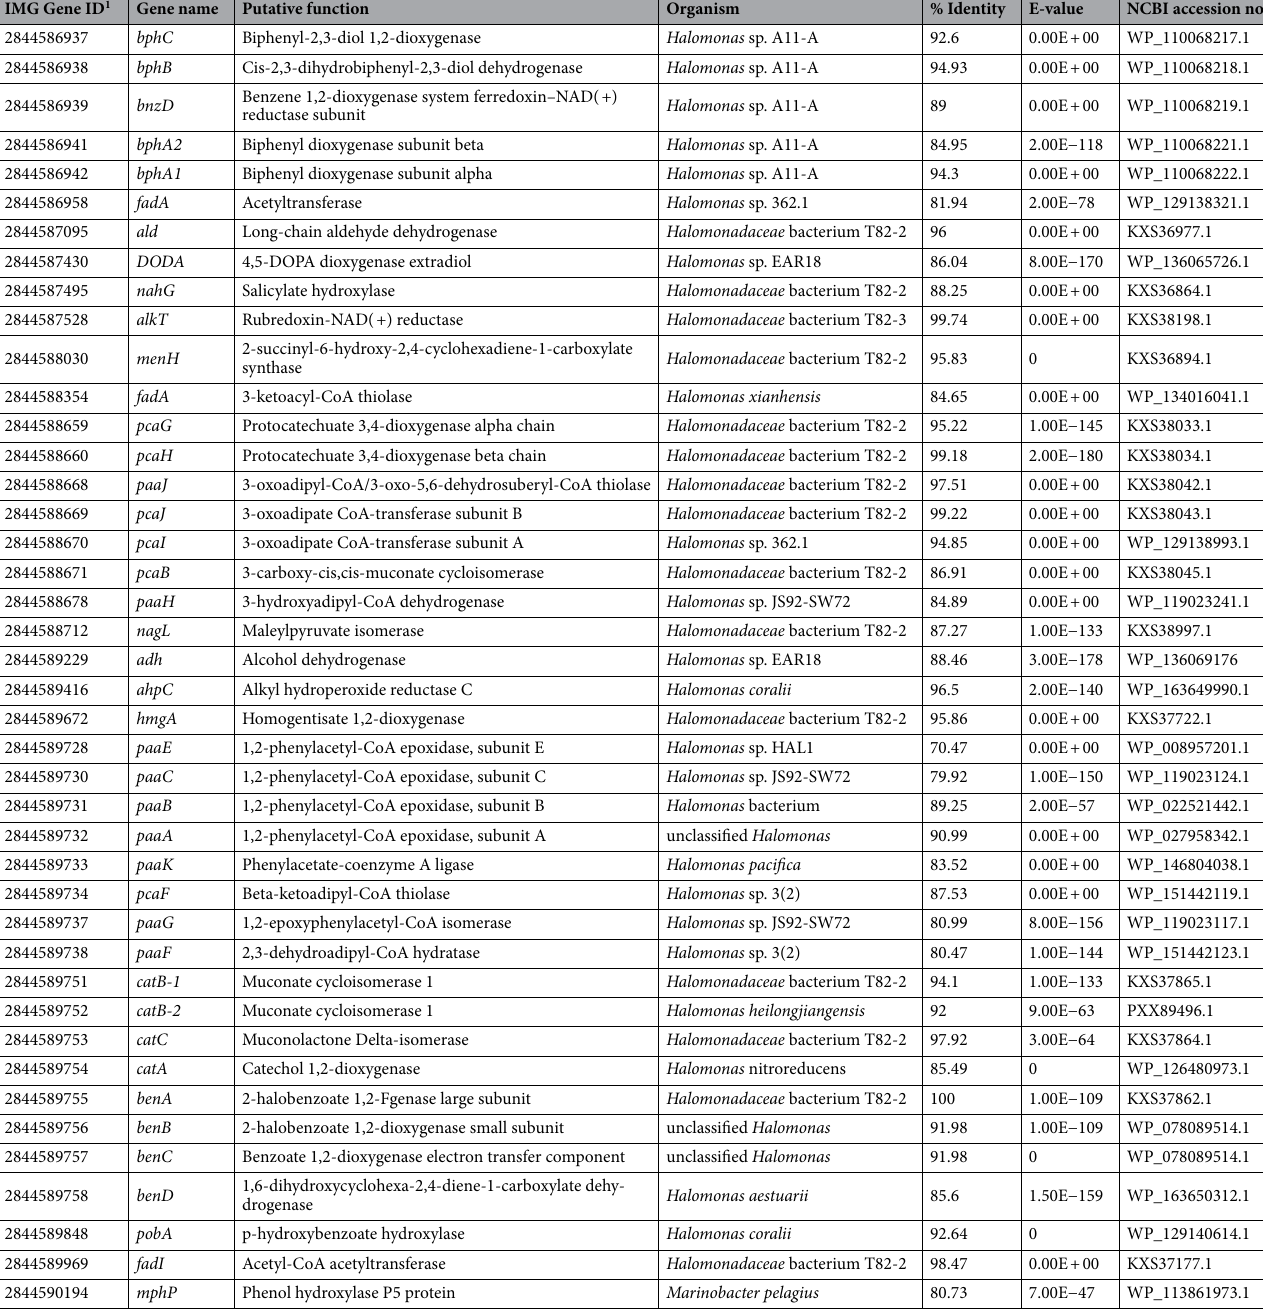
Table 1. Putative functions and top homologs of Modicisalibacter sp. strain Wilcox genes predicted to encode proteins involved in metabolism of hydrocarbons. 1 Gene sequences were BLAST p searched against NCBI nr database in NCBI for top